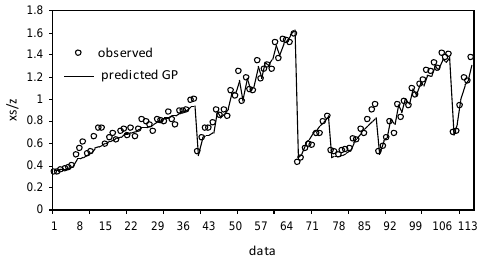
Figure 16. GP estimations of XS/z versus measured ones 00.10.20.30.40.50.60.7